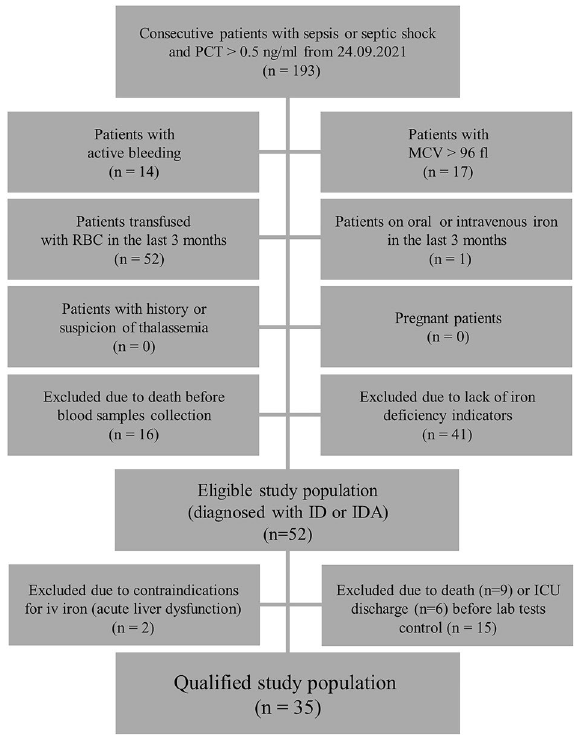
Figure 1. The study flow